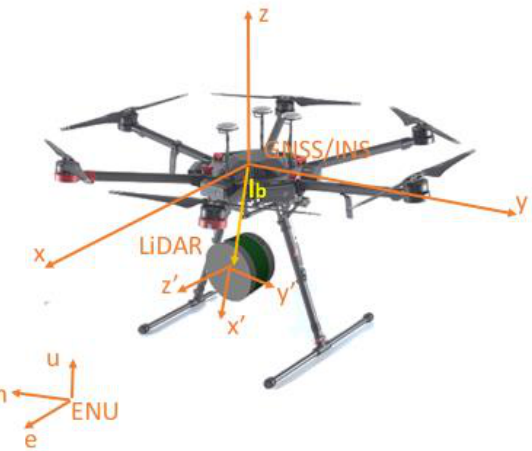
Figure 8. Reference frames used for the georeferenced point cloud generation.